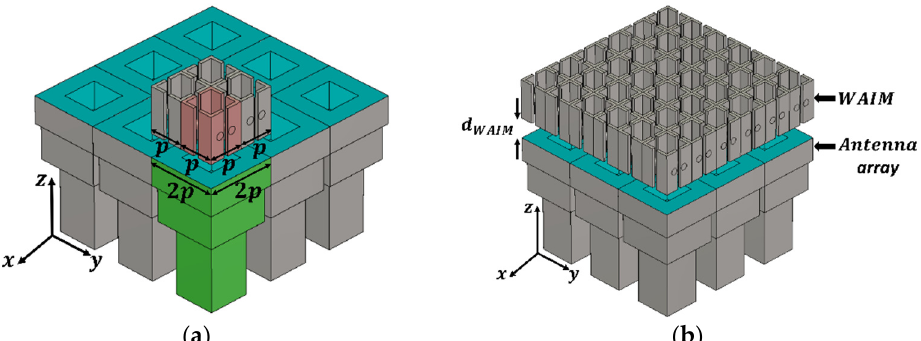
Figure 7. ( a ) Phased array of stepped horns with four unit-cells with half-periodicity (one unit-cell represented in red) per one array element (represented in green) (illustrative) and ( b ) global structure: phased array plus WAIM structure with infinite periodic conditions.